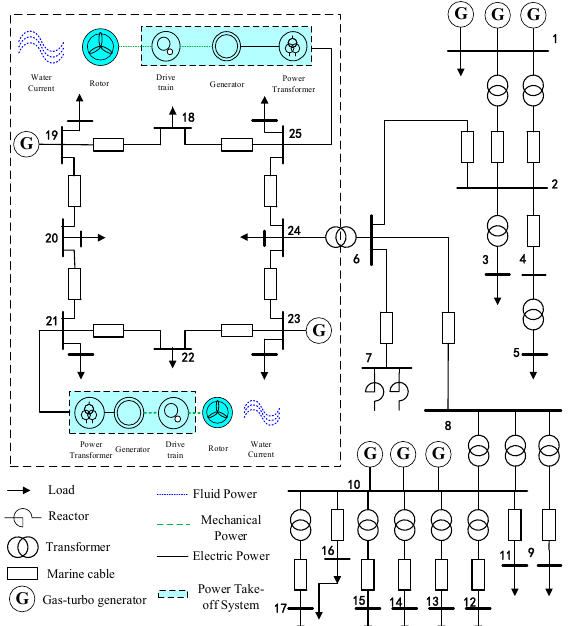
ff shore microgrid in grid-connected operation Figure 12. Offshore microgrid in grid-connected operation mode. Figure 12. Offshore microgrid in grid-connected operation mode. Figure 12. O Figure 12. Offshore microgrid in grid-connected operation mode.